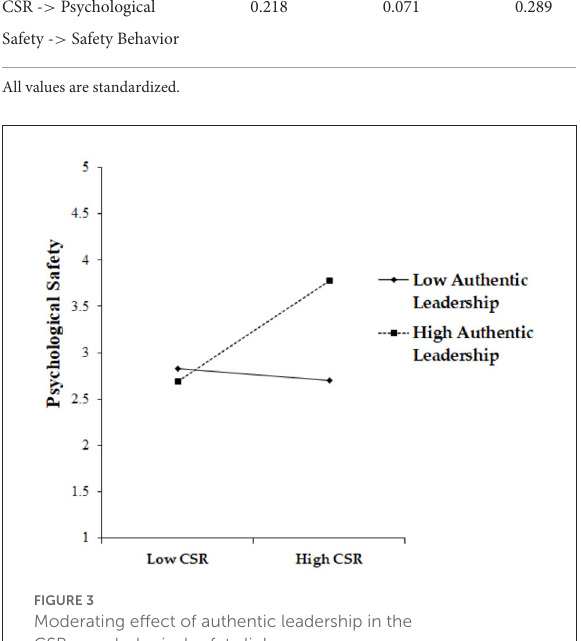
FIGURE3 Moderating effect of authentic leadership in the CSR–psychological safety